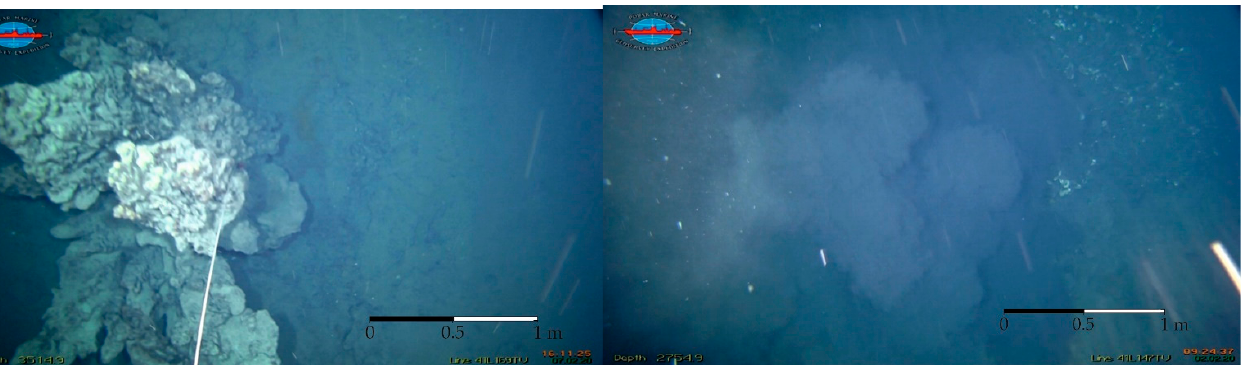
Figure 8. On the ( left ) a hydrothermal building in the area of the Molodezhnoye HF; on the ( right ) “smoke” from a black smoker in the area of the Koralovoye HF.